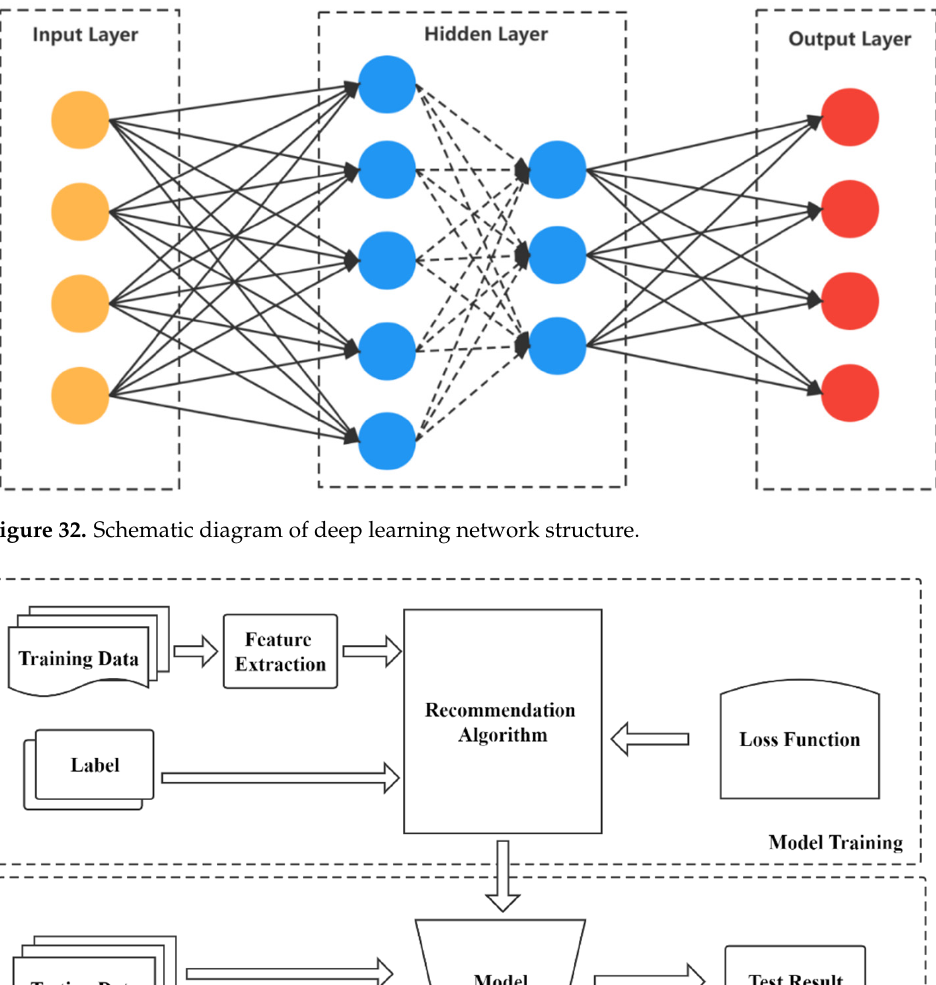
Figure 32. Schematic diagram of deep learning network structure.